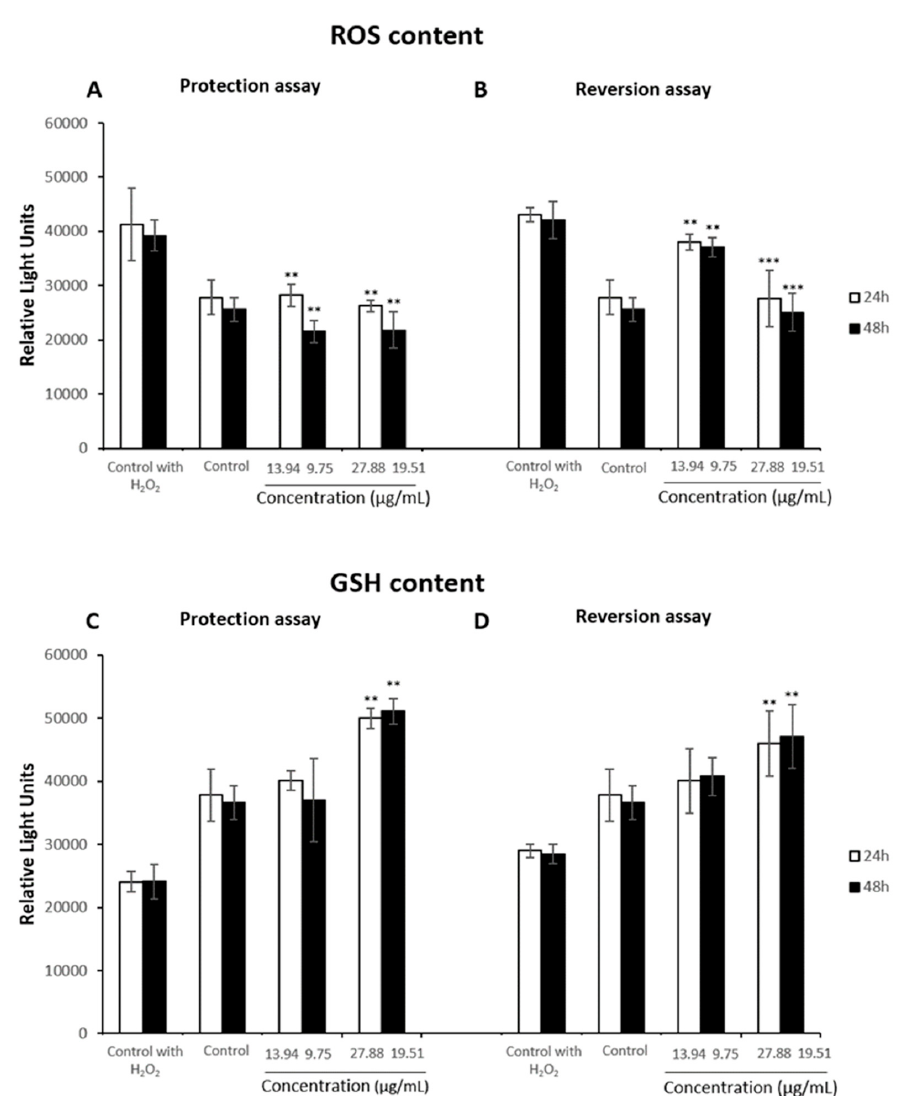
Figure 8. ROS ( A ) and GSH content ( C ) in Caco-2 cells first pretreated with 0–27.88 μ g/mL or with 0–19.51 μ g/mL of the extract for 24 h or 48 h, respectively, and a later exposure to H 2 O 2 100 μ M for 2 h. ROS ( B ) and GSH ( D ) content in HepG2 cells exposed to H 2 O 2 100 μ M first and a later 24 h or 48 h-treatment with 0–27.88 μ g/mL or 0–19.51 μ g/mL respectively. Cells exposed to H 2 O 2 100 μ M 2h were used as control. All values are expressed as mean ± SD. Differences were considered significant compared to the control group from p < 0.01 (**) and p < 0.001 (***).